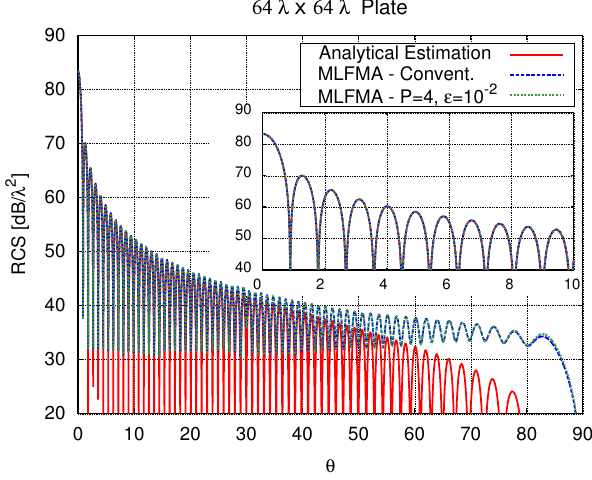
Figure 10: Bistatic RCS of a square PEC plate ( a = 64 λ ) with 1 085 544 unknowns, computed with the a